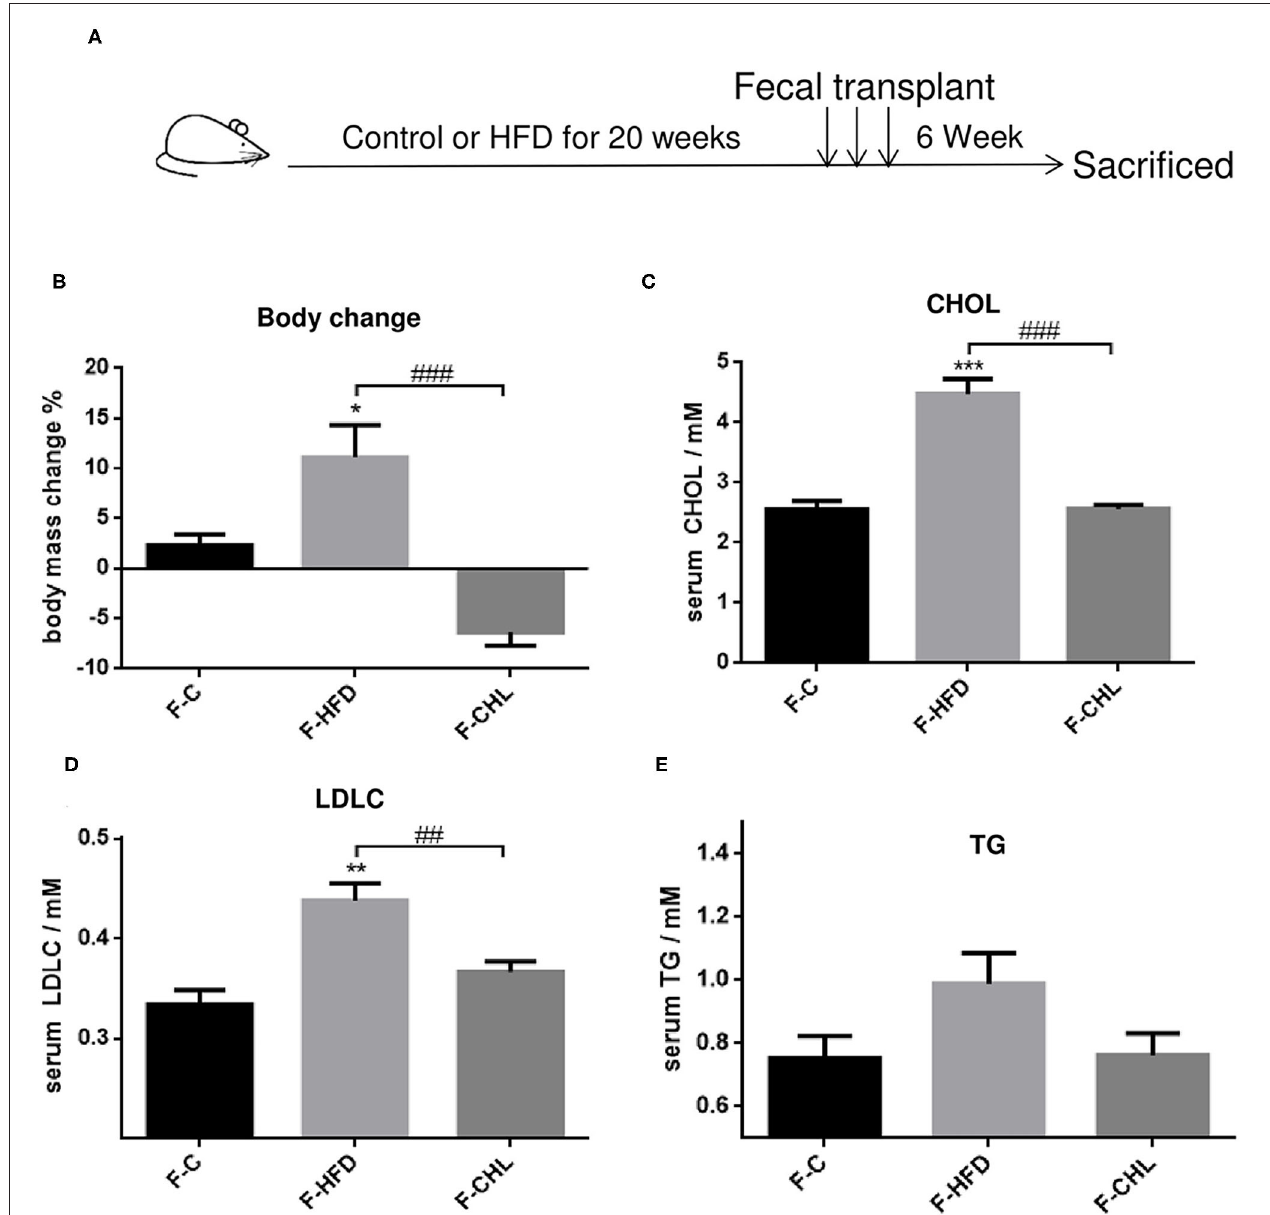
FIGURE 10 | Fecal flora transplant from CHL-treated mice improves metabolic parameters of the mice fed with an HFD. (A) Experiment design for fecal flora transplant. (B) Bodyweight of the recipient mice at the end of the experiment. (C) Plasma cholesterol levels of the recipient mice at the end of the experiment. (D) Plasma levels of low-density lipoprotein cholesterol (LDLC) by the recipient mice at the end of the experiment. (E) Plasma levels of triglycerides and n = 6 for each group. Values are mean ± SEM; * p < 0.05, ** p < 0.01, *** p < 0.001 vs. Ctrl group; ## p < 0.01, ### p < 0.001 vs. HFD group.